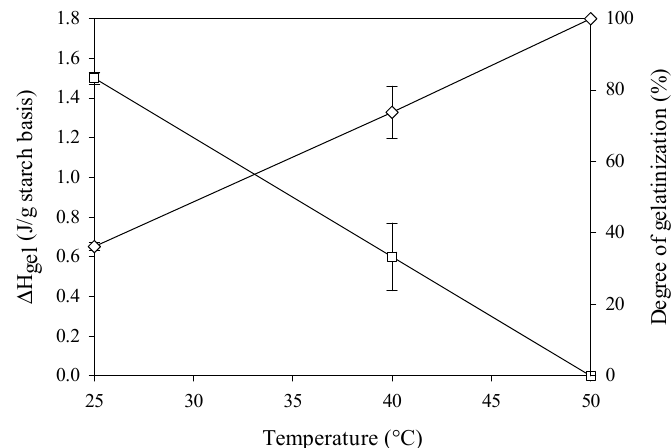
Temperature (°C) Figure 4. ∆ H gel (J / g starch, open square) and degree of gelatinization (%, open diamond) as a function of HHP processing temperatures of potato starch suspensions (25 µ m, 20% w / w) treated at 600 MPa for 15 min.